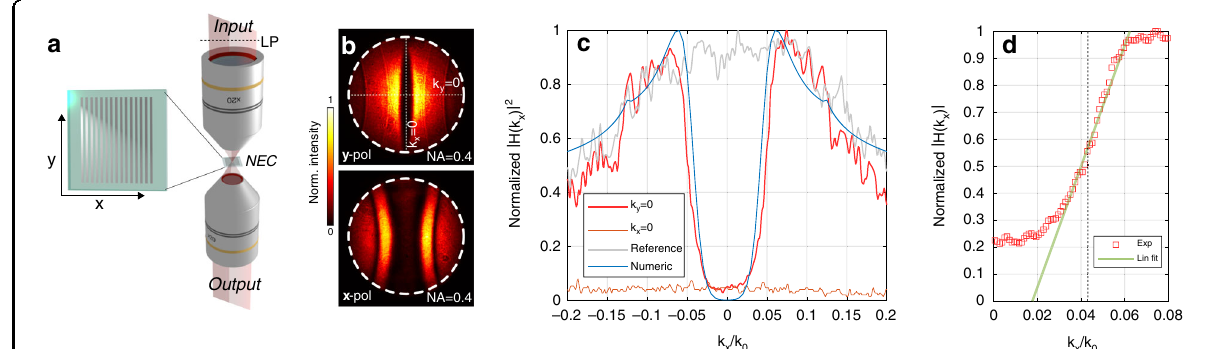
Fig. 2 Experimentally measured optical response of the fabricated device. a The con fi guration for measuring the optical transfer function. A linear polariser selects the required polarisation direction relative to the direction of the grating stripes. The output lens produces a Fourier plane image. b The experimentally measured normalised two-dimensional modulation transfer function Mð k x ; k y Þ pol) and perpendicular to the silver grating stripes ( x -pol). The measurement wavelength was λ = 637 nm. c Pro fi les along the dashed lines in b (red lines) highlighting the suppression of the direct beam. The corresponding simulated pro fi le for s -polarisation is given for comparison (blue) with the spatial-frequency content of the incident beam (grey). d The normalised modulation transfer function Mð k x ; k y Þ small tilt in the incident beam relative to the surface normal of the NEC shifts the spatial-frequency origin (dashed line) introducing an asymmetry into the optical transfer